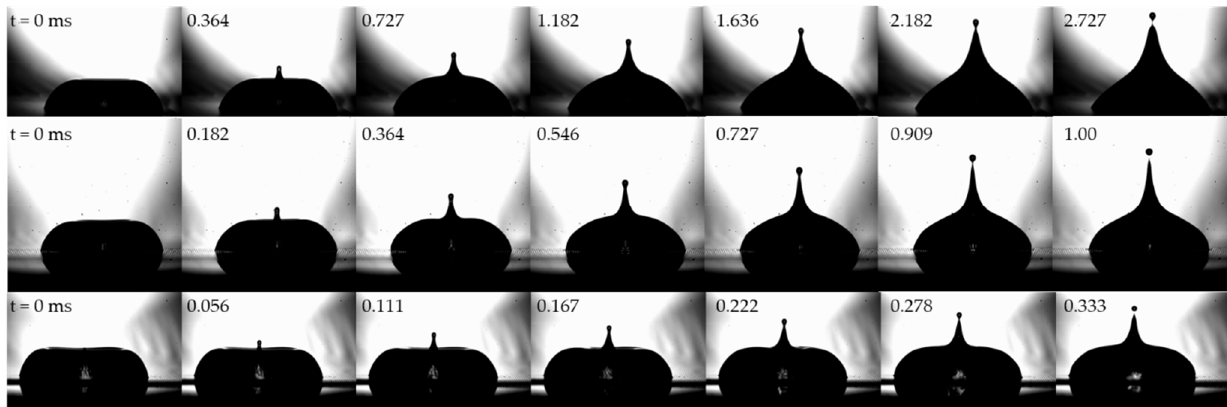
Figure 2. Images showing a typical jet evolution versus time for three different fluids. Top row: 55% G solution ( Oh = 0.023, U i = 0.754 m/s, We = 26.9, Re = 223.9), middle row: 37.5% G solution ( Oh = 0.0089, U i = 0.741 m/s, We = 23.9, Re = 553.4), bottom row: 10% G solution ( Oh = 0.0029, U i = 0.741 m/s, We = 21.4, Re = 1580.3).